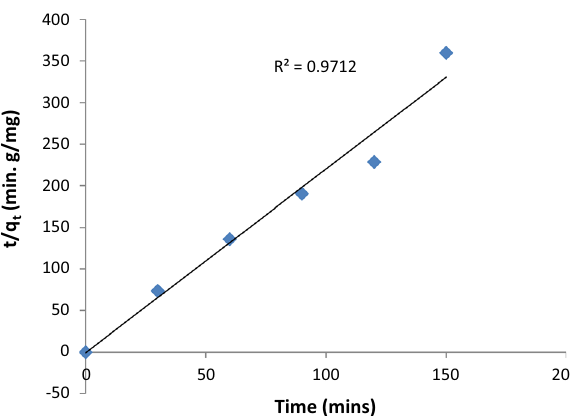
Fig. 10 Pseudo-second-order plot on sorption of Estuary crude oil onto FBPC